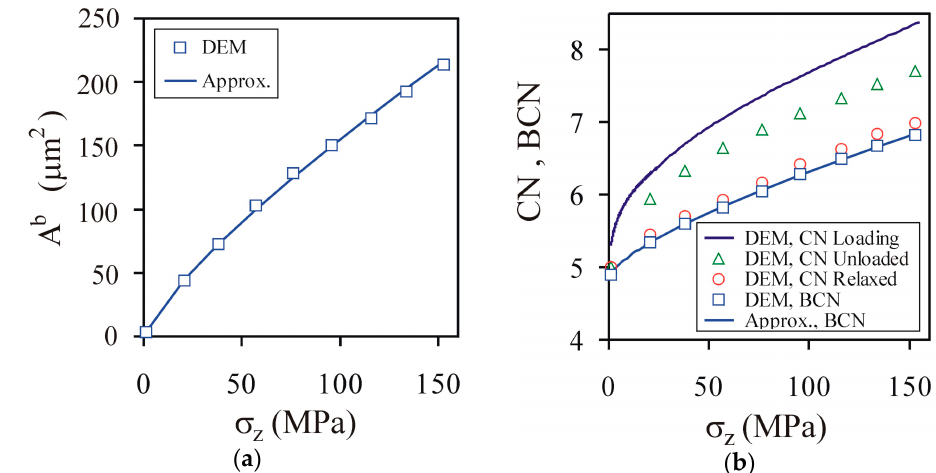
Figure 12. Effects of the compaction pressure on ( a ) the bond cross-sectional area A b , as well as ( b ) the coordination number CN and the bond coordination number BCN .